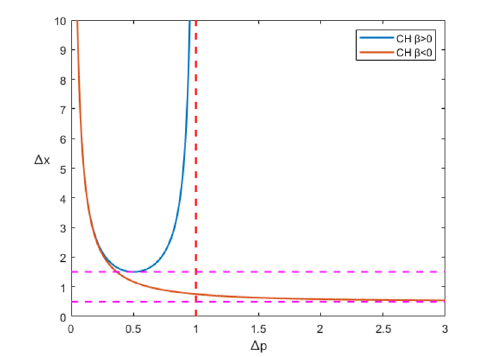
Figure 3 . The ∆ x as the functions on ∆ p given by CH for β > 0 and β < 0 . The red and pink dotted lines respectively represent the positions of the maximum momentum and the minimum length.